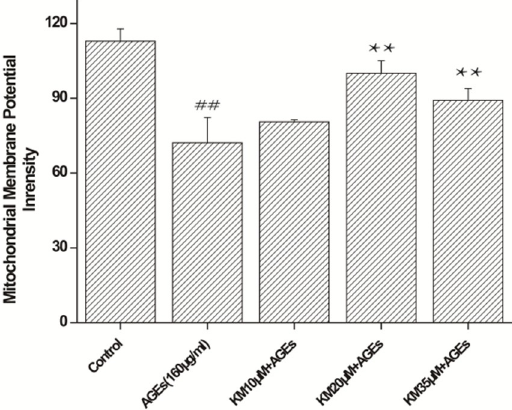
Figure 4. KM treatment improves mitochondrial membrane potential recovery in AGE-treated GMCs. Detection of the changes in mitochondrial membrane potential (∆Ψm) using rhodamine 123. GMCs were pre-treated with 10, 20, or 35 μM KM and then stimulated with AGEs (160 μg/mL) for 24 h. The results are presented as mean ± SEM. ** p < 0.01, vs. AGE group; ## p < 0.01, vs. control group.